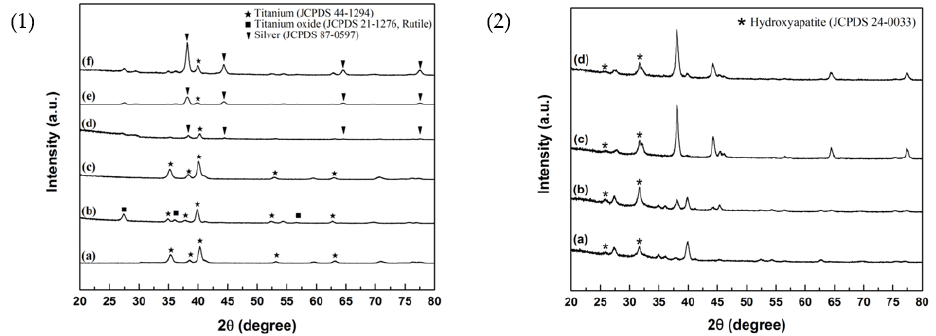
Figure 3. ( 1 ) XRD patterns of (a) SLA Ti, (b) Oxide Ti, (c) MBG–coated Ti, (d) MBG–Ag1–coated Ti,